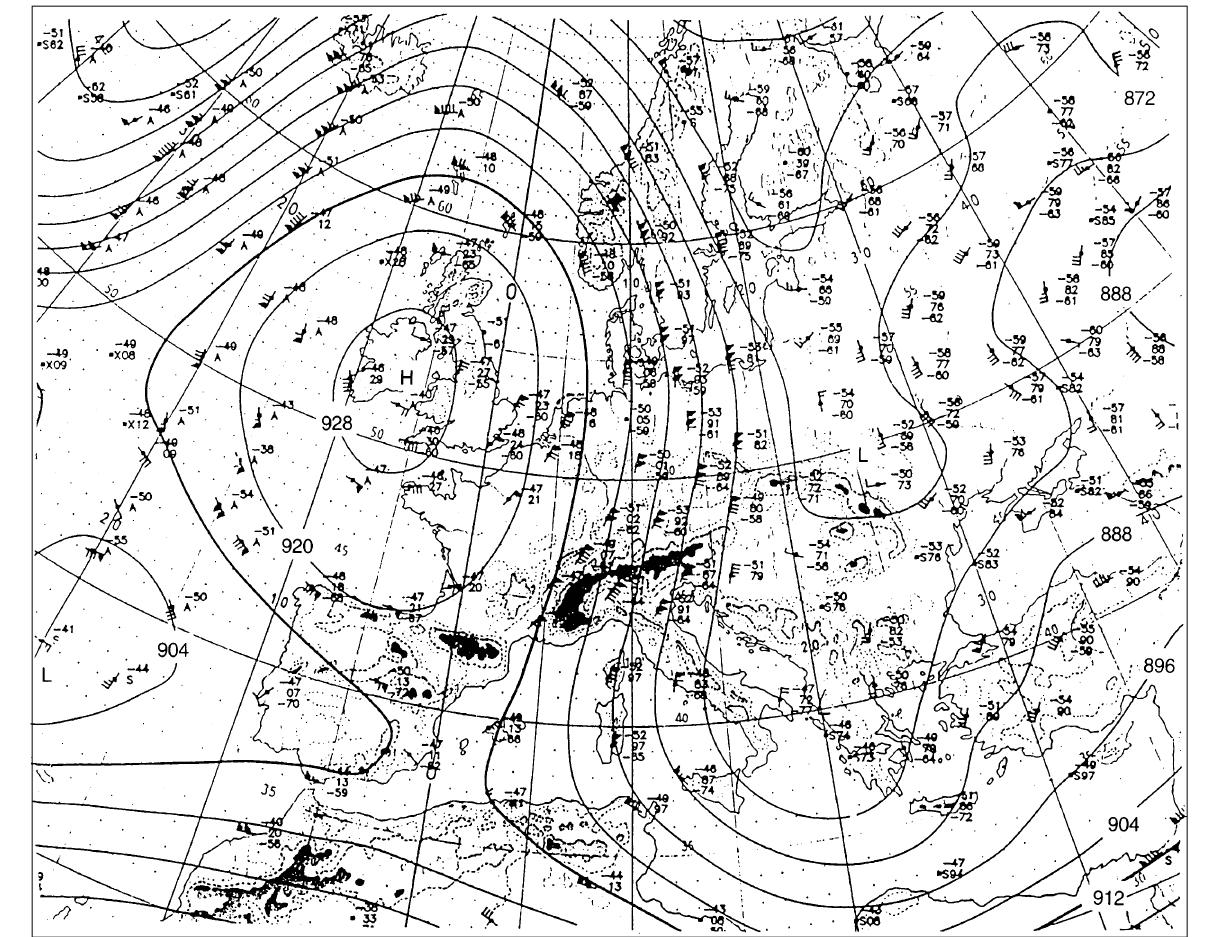
Fig. 6. 6 March 1993: 300-hPa map (Courtesy of European Meteorological Bulletin, Germany)